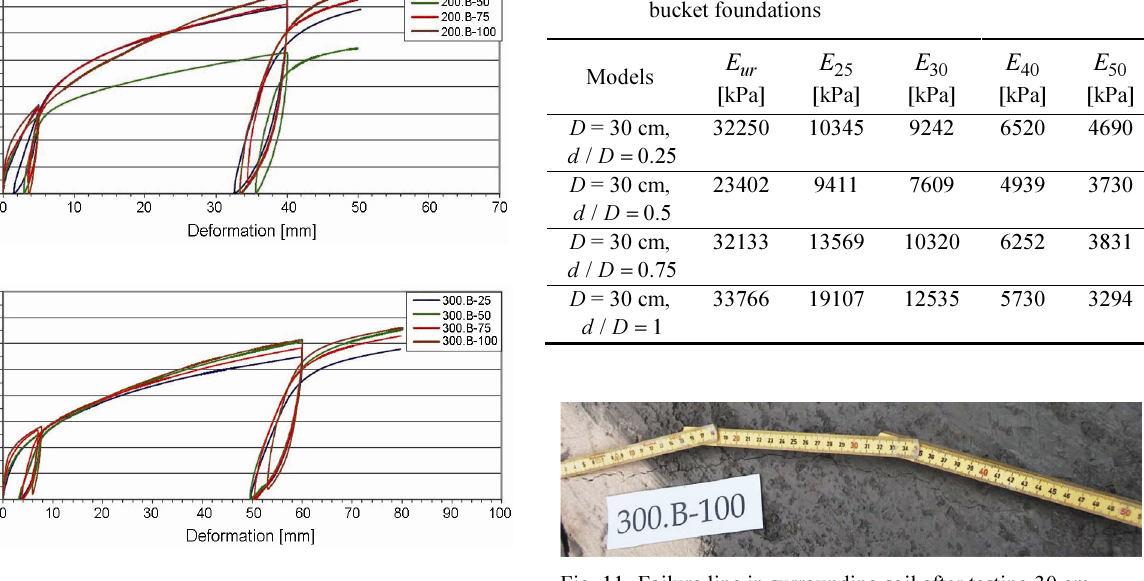
Fig. 10. Stress-displacement curves obtained during 20- and